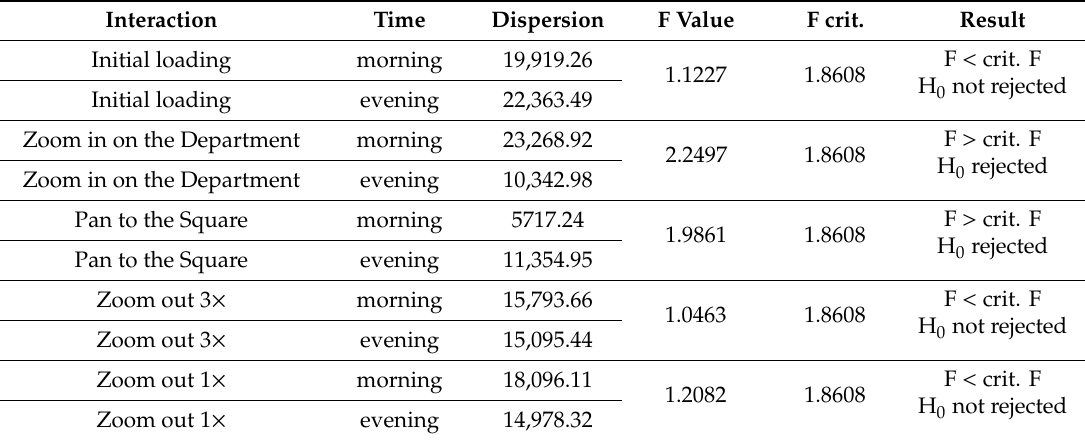
Table 3. F-test results: morning vs.